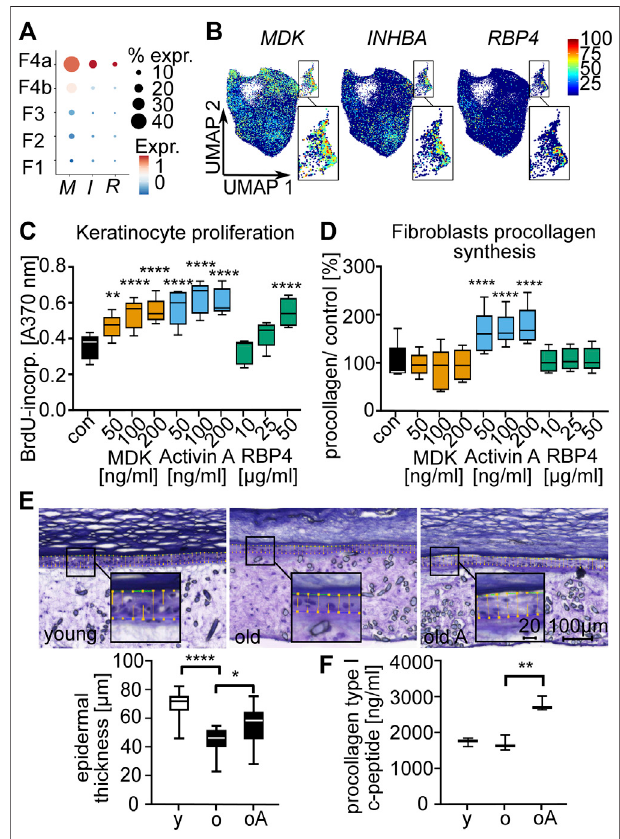
FIGURE 6 | Secreted proteins of the dermal sheath mediate paracrine effects on fi broblasts and keratinocytes and contribute to a juvenile skin phenotype. Expression of INHBA (I), MDK (M) and RBP4 (R) among the fi broblast populations (A) in dot plot and (B) in Uniform Manifold Approximation and Projection plots. Box plots of (C) proliferation of old keratinocytes and (D) procollagen type I c-peptide synthesis of old fi broblasts after treatment with secreted proteins MDK, Activin A and RBP4 for 72 h, n (cid:1) 5,* p < 0.05, ** p < 0.01,*** p < 0.001,**** p < 0.0001(RMone-wayANOVA with Dunnett multiple testing correction). (E) Epidermal thickness of 3D skin equivalents stained with Diff-Quick (microscopy images) and (F) procollagen synthesis. Comparison of young (y) vs. old (o) and old vs. old Activin A treated (100 ng/ml for 6 weeks, old A/oA) (box plots), n (cid:1) 3, 5 slices were used for each n to determine epidermal thickness, * p < 0.05, ** p < 0.01, *** p < 0.001, **** p < 0.0001 (two-tailed un/paired t